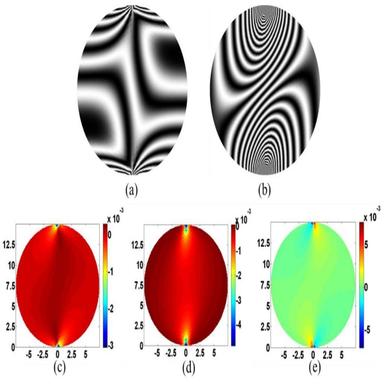
Fringe patterns of the displacement fields along (a) the x axis and (b) the y axis, and strain fields (c) ɛxx, (d) ɛyy, and (e) xy of the simulation model.